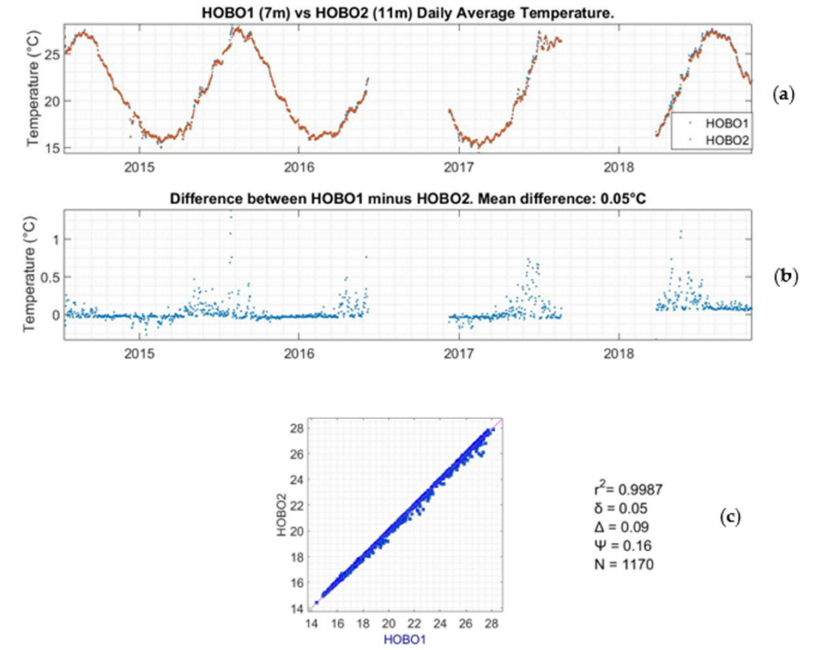
Figure 4. ( a ) Data series of the HOBO1 logger deployed 7 m below sea surface compared with the HOBO2 logger data that is deployed 11 m below the sea surface. Data points are the daily averaged values of each sensor only from days that both sensors recorded data. ( b ) Di ff erence between the HOBO1 minus the HOBO2 daily averaged data. ( c ) Correlation plot for the comparison between the HOBO1 and HOBO2 data (refer to Section 2.4 for definitions).